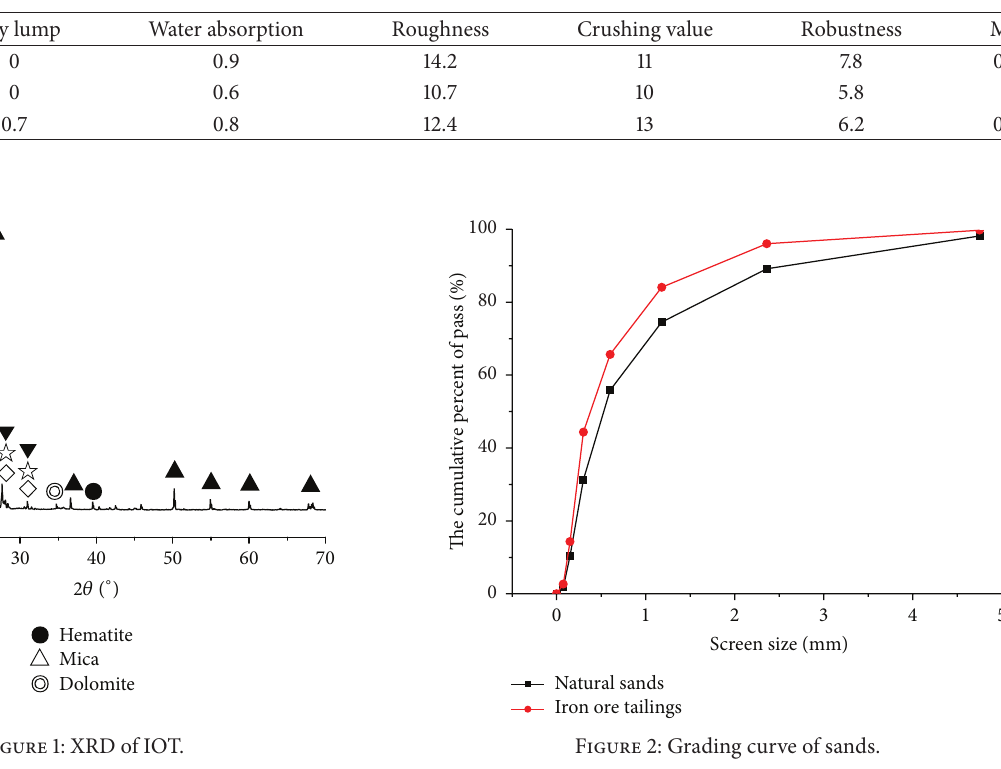
Table 2: Physical properties of three kinds of sands (%).